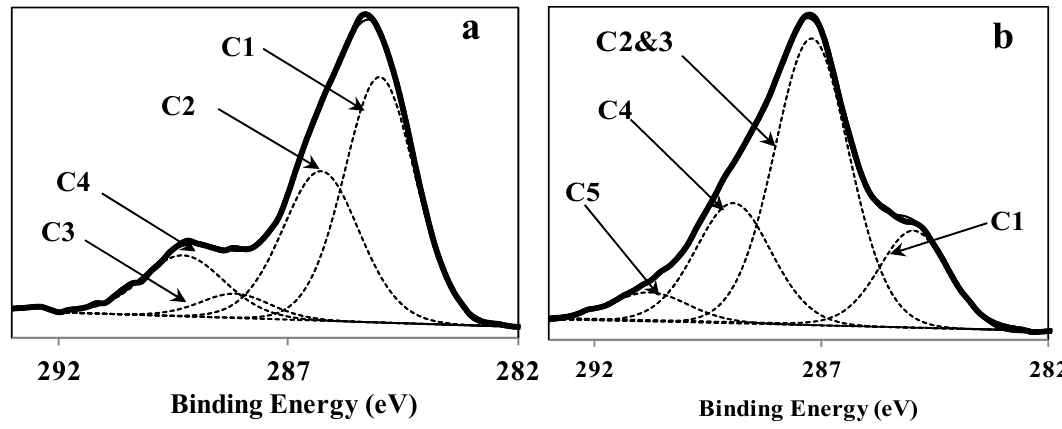
Figure 1. Deconvoluted C 1s XPS high resolution spectra of ( a ) chemically retted; and ( b ) inorganic nanoparticle impregnated kenaf bast fibers.